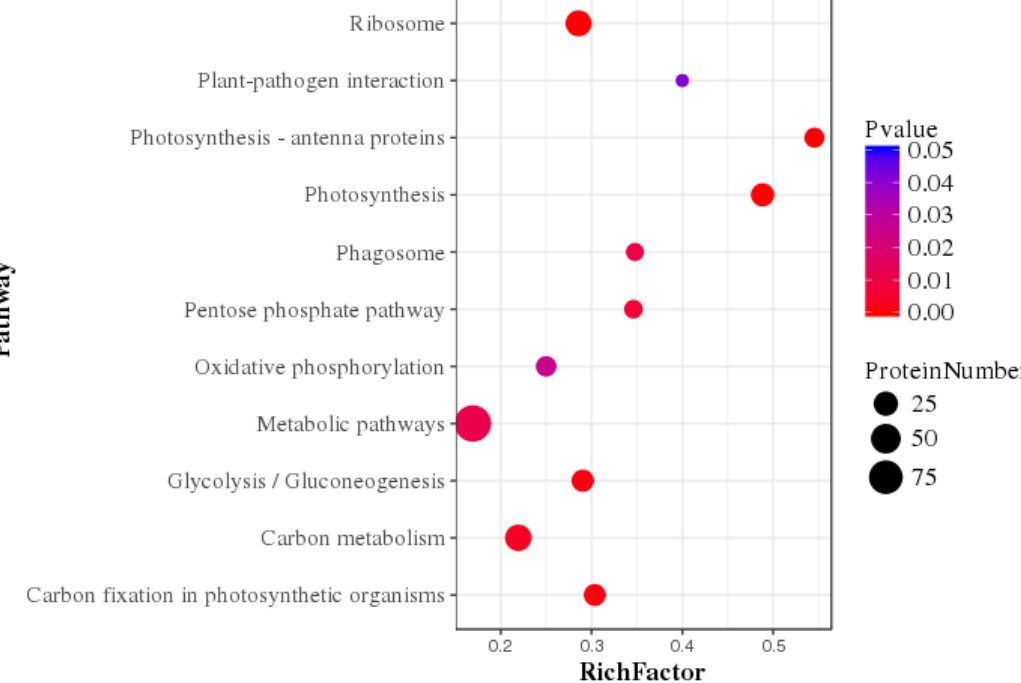
Figure 3. Statistics of pathway enrichment factor analysis of differentially expressed proteins comparing of Si-limited vs. Si-added conditions.